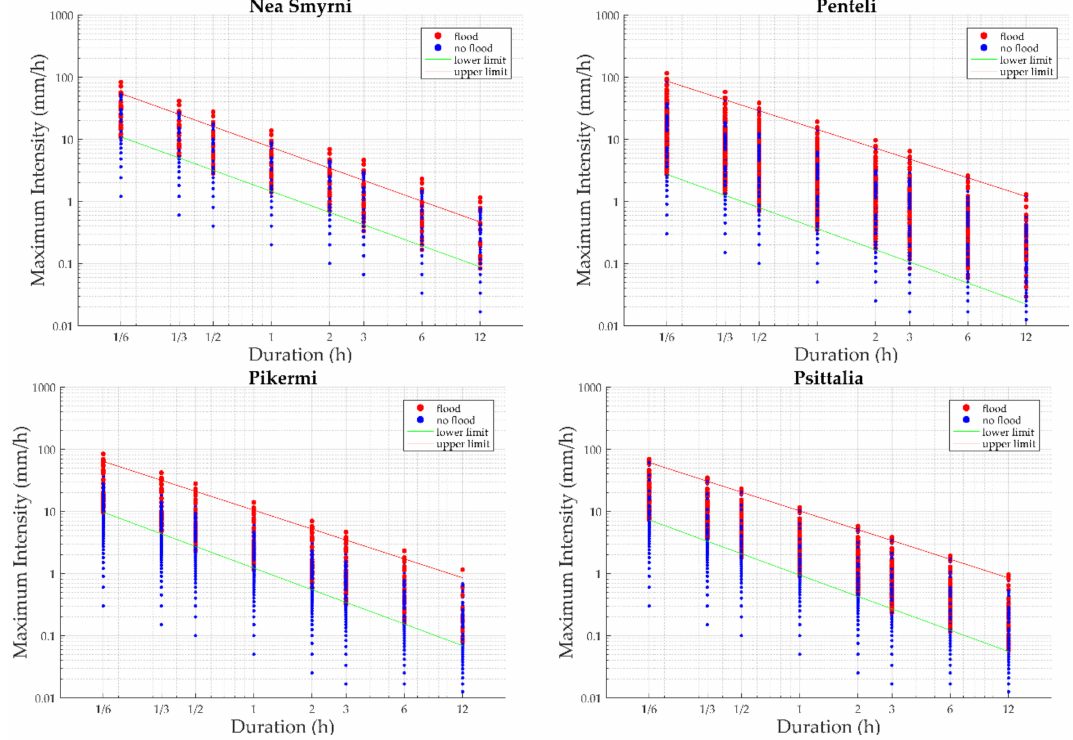
Figure 4. Maximum rainfall intensity–duration thresholds and areas #1, #2, and #3 for all